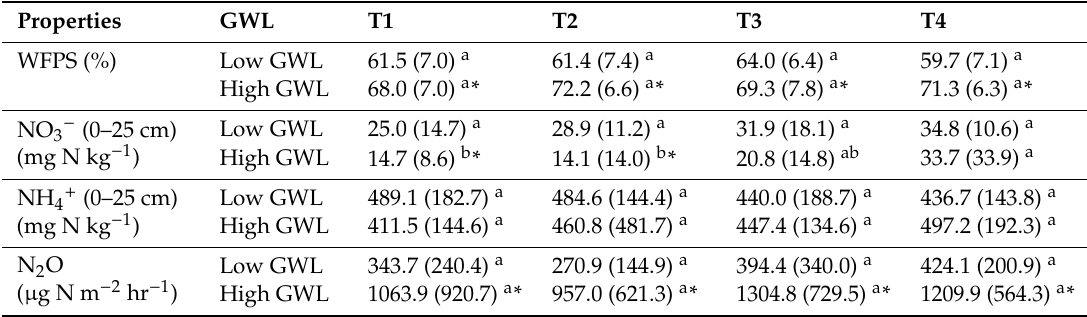
Table 4. Mean WFPS, NO 3 − concentrations, NH 4 + concentrations, and N 2 O emissions for